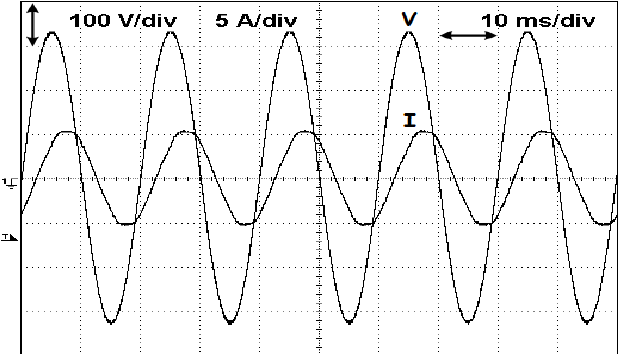
Figure 13. Waveforms of the voltage and current in phase L 1 of the testing system obtained from the test using the PV inverter with four legs for a balanced condition and with reactive compensation.